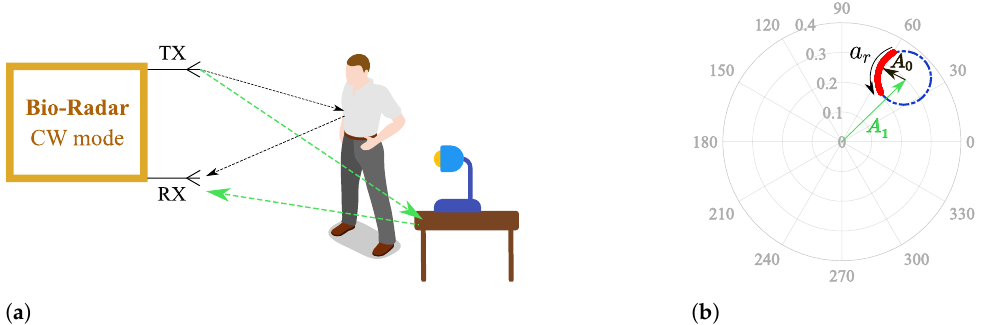
Figure 2. Illustration of the effect of a static scenario in the complex plane: ( a ) Reflections schematics on the monitoring environment, ( b ) Equivalent projection of the received signal on the complex